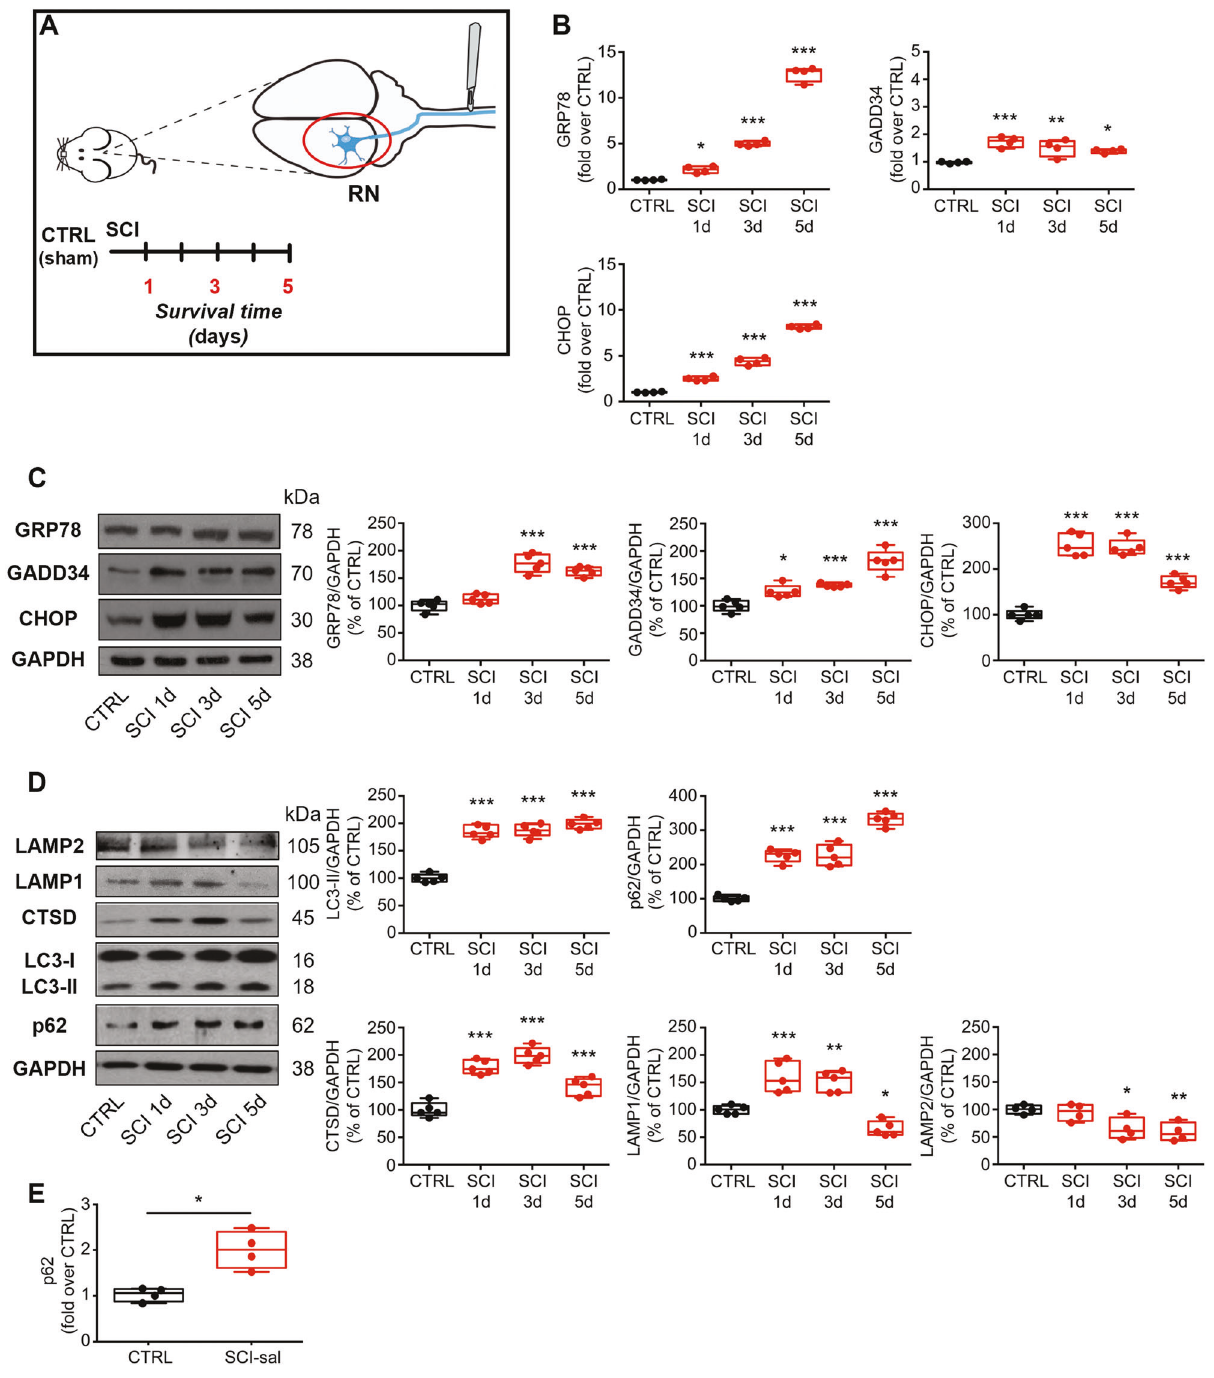
Fig. 1 Spinal cord injury induces ER stress and autophagy fl ux disruption in remote regions. A Schematic of the protocol used in the study. Adult rats underwent spinal cord injury (SCI), or sham lesion (CTRL). At day 1, 3 and 5 SCI animals were sacri fi ced and the red nucleus (RN) contralateral to the lesion side was extracted and processed for biochemical analyses or analyzed on fi xed-brain sections. B Box-and-whisker plots of GRP78, GADD34 and CHOP mRNA level in control animals (CTRL) and after spinal cord injury (SCI) at various time points after damage (1, 3, and 5 days), expressed as fold over CTRL ( N = 5 rats per group; one-way ANOVA, p = 511.1 GRP78; p = 11.87 GADD34; p = 532.3 CHOP) *** p <0.001, ** p <0.01, * p <0.05 vs CTRL. C Representative western blot and densitometric box-and-whisker plots from the CTRL and SCI animals at different time points after injury showing the levels (expressed as % of CTRL) of GRP78, GADD34 and CHOP normalized to GAPDH used as loading control ( N = 5 rats per group; one-way ANOVA, p <0.0001 GRP78; p <0.0001 GADD34; p = 0.0001 CHOP) *** p <0.001, ** p <0.01, * p <0.05 vs CTRL. D Representative western blot and densitometric box-and-whisker plots from the different groups showing the levels (expressed as % of CTRL) of LC3, p62, CTSD, LAMP1, and LAMP2 normalized to GAPDH used as loading control ( N = 5 rats per group; one-way ANOVA, p <0.0001 LC3-II; p <0.0001 p62; p <0.0001 CTSD; p <0.0001 LAMP1; p <0.01 LAMP2). *** p <0.001, ** p <0.01, * p <0.05 vs CTRL. In all box-and-whisker plots of the present study the centre line shows the median value, edges are upper and lower quartiles, whiskers show minimum and maximum values, and each point is an individual animal. E Box-and-whisker plots of p62/SQSTM1 mRNA level in CTRL and SCI-sal as fold over CTRL ( N = 4 rats per group; Unpaired t -test with Welch's correction p = 0.0125) * p <0.05. Cell Death and Disease (2022)